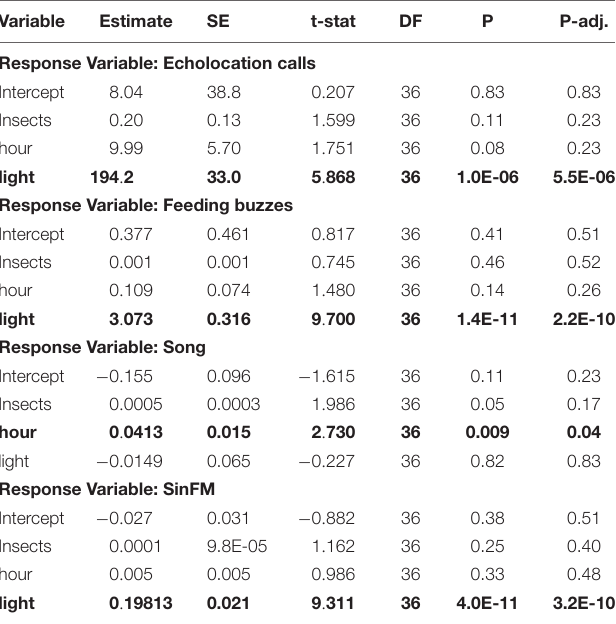
TABLE 1 | Effects of environmental variables on acoustic activity of bats as determined by generalized linear mixed effects models. Variable